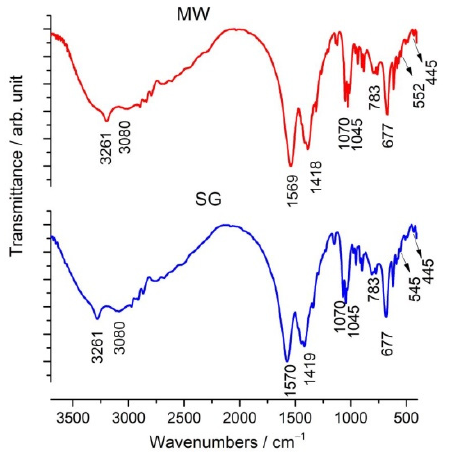
Figure 2. FTIR spectra of the V-doped ZnO gels obtained by the microwave assisted sol–gel method (MW) and the sol–gel method (SG).